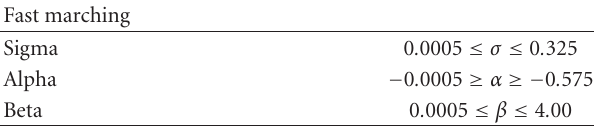
Table 1: Internal constraints for fast marching level